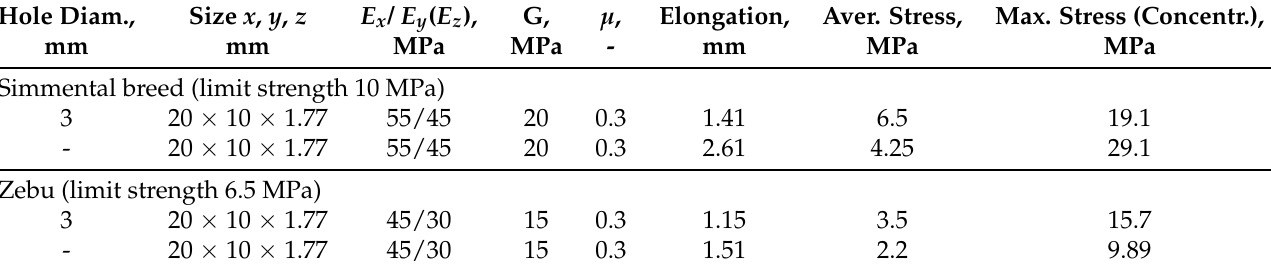
Table 4 contains input data and results of the numerical calculation of two leathers (Simmental breed and zebu) exposed to static tensile loading. The same general geometry of samples with elastic properties, corresponding to similar leather types, is used. Table 4. Simulation data for